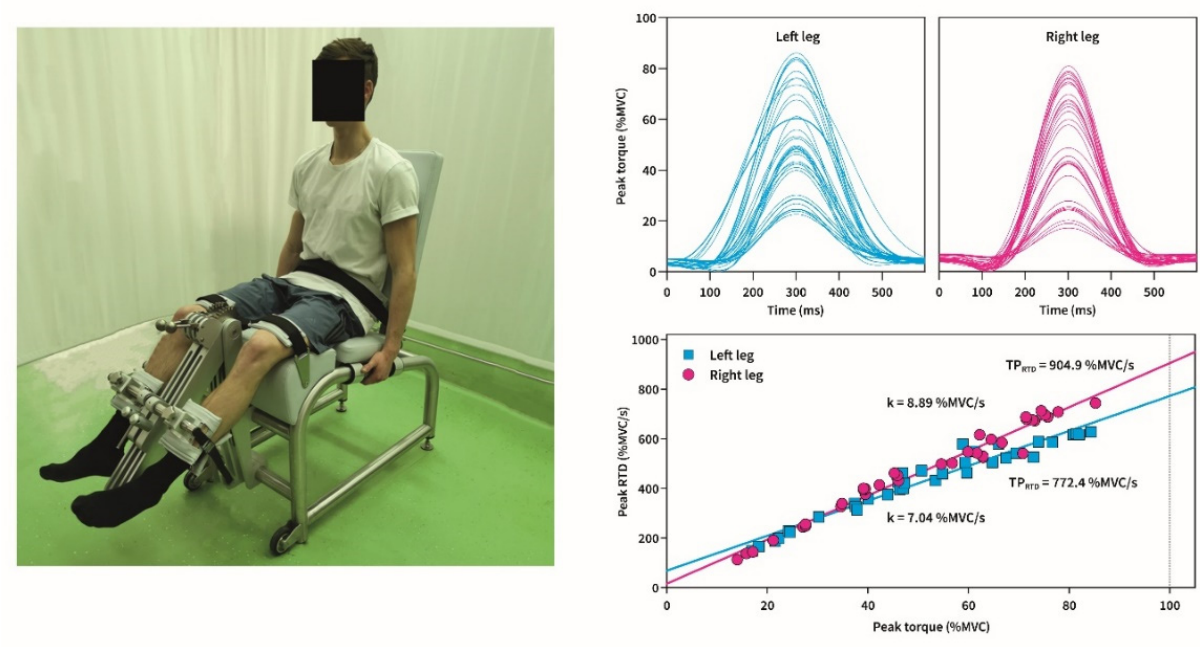
Figure 1. Representative position of the participant in the knee dynamometer (left side); sample recording of torque pulses (individual subject) from the rate of force development scaling factor (RFD-SF) protocol for each leg (top); regression lines (individual subject) depicting the relationship between peak RTD and T max for each leg (bottom); k-slope of regression line (rate of force development scaling factor); TP RTD -theoretical peak of RTD.